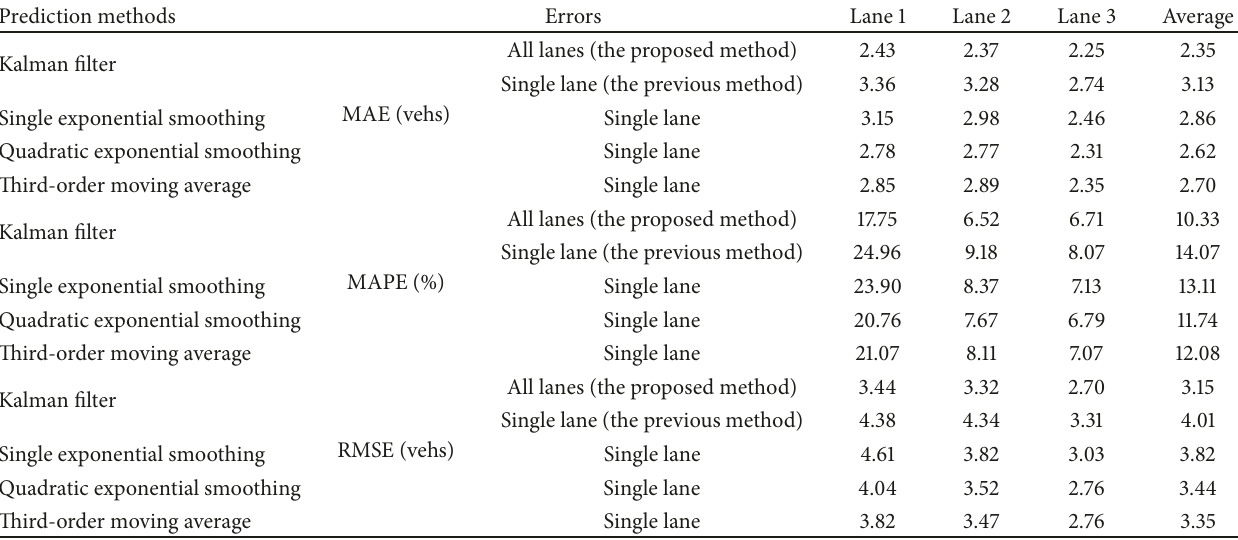
Table 3: MAE, MAPE, and RMSE of the predictions of traffic volume proportion in each lane.